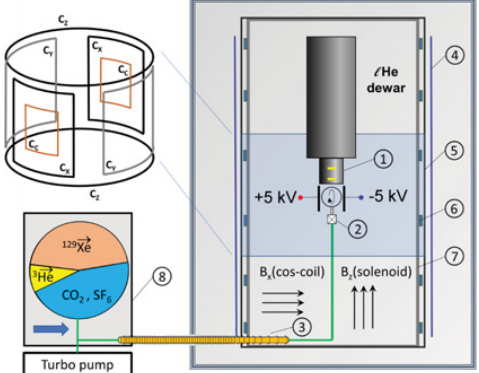
Figure 3. Setup of the MIXed 129 Xe-EDM experiment. The central part of the experiment, i.e. the SQUID-gradiometer (1) and the EDM cell (2), is placed inside a two-layer magnetically shielded room (MSR) with an additional mu-metal cylinder (4) to reduce magnetic field gradients. A coil system consisting of a cosine-coil (5) and a solenoid (6) generates a homogeneous magnetic guiding field. Four additional shimming, coils (shown in the top-left corner) are used to compensate gradients. A fibre- reinforced plastic tube (7) acts a rigid mounting structure for all components inside the MSR. The gas mixture of hyperpolarized 3 He and 129 Xe, and buffer gases is prepared outside the MSR (8) and then transferred through filling lines equipped with solenoids (3) to the EDM cell.